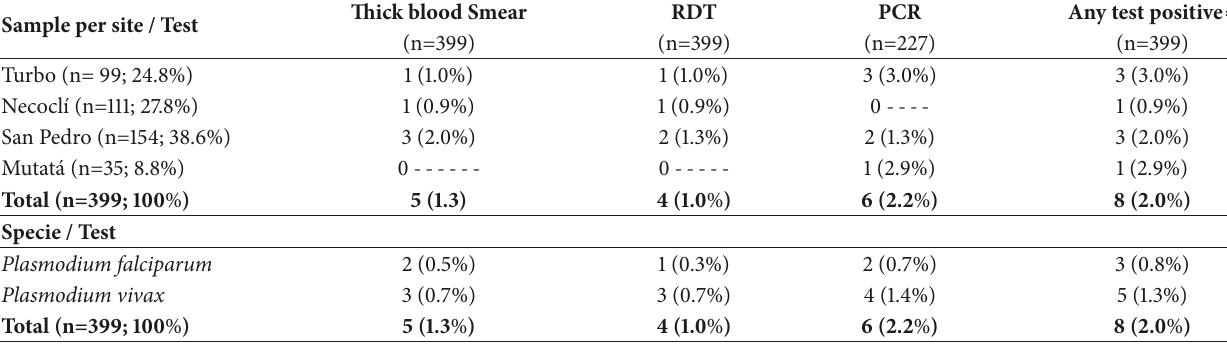
Table 2: Thick blood smear, RDT, and PCR positive results per municipality and species of Plasmodium . Sample per site / Test